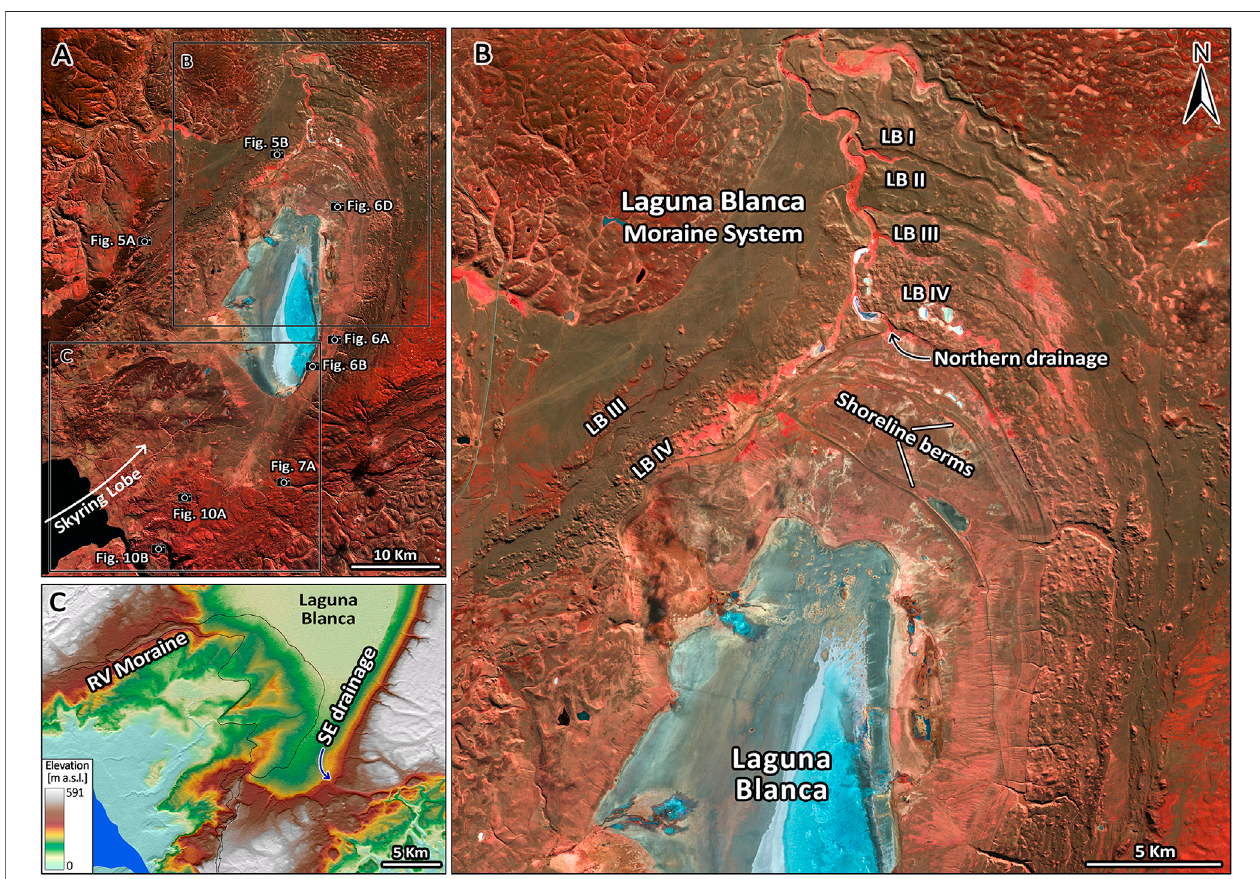
FIGURE 2 | (A) Sentinel 2 (band combination 843) image of the Seno Skyring ice lobe area. Former ice fl ow of the Skyring lobe was directed from Seno Skyring north-easttotheRíoVerde(RV)andLagunaBlanca(LB)morainesystems. (B) DetailedimagewithfocusonLBmorainesystem,showingitsfourdifferentmorainebelts, from older to younger LB I, LB II, LB III and LB IV respectively. Former shoreline berms and a northern drainage spillway of the palaeo Laguna Blanca are indicated. (C) Hillshade and elevation colour ramp (SRTM) of the area around RV moraine system, black lines indicate the RV moraine extension. The south-eastern drainage spillway of the palaeo Laguna Blanca is marked. Note that the altitude of this drainage spillway is higher than the central (front) parts of the RV moraine, implying an ice dam must have been present.